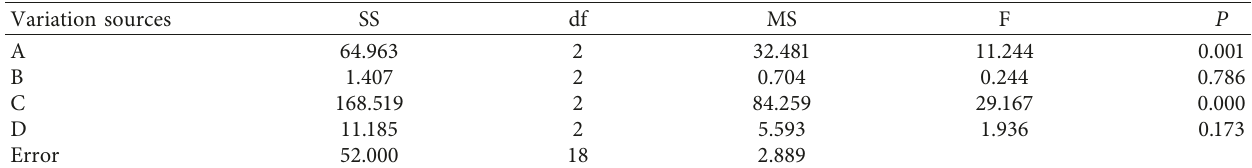
Table 3: Variance analysis